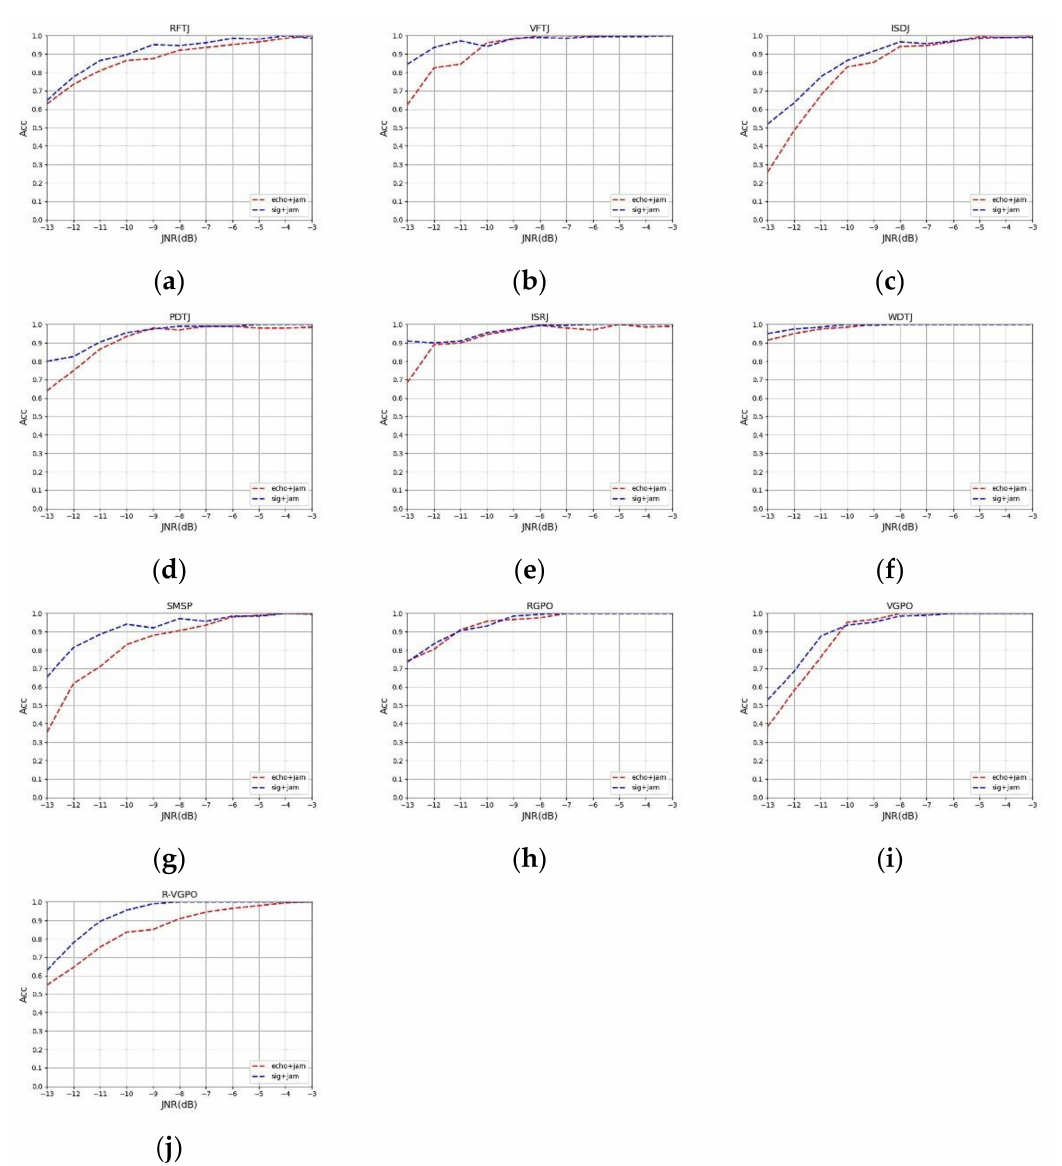
Figure 10. Comparison of recognition accuracy of 10 kinds of jamming between jamming plus echo and jamming plus original signal. ( a ) RFTJ. ( b ) VFTJ. ( c ) ISDJ. ( d ) PDTJ. ( e ) ISRJ. ( f ) WDTJ. ( g ) SMSP. ( h ) RGPO. ( i ) VGPO. ( j )